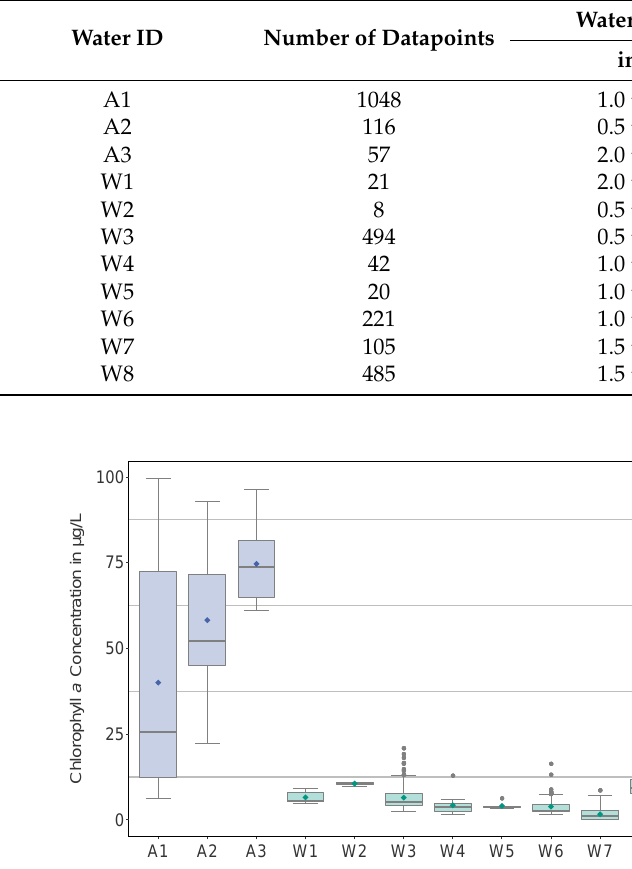
Table 1. Summary of the SpecWa dataset [43]. The term ap refers to artificial pond while qp means quarry pont.